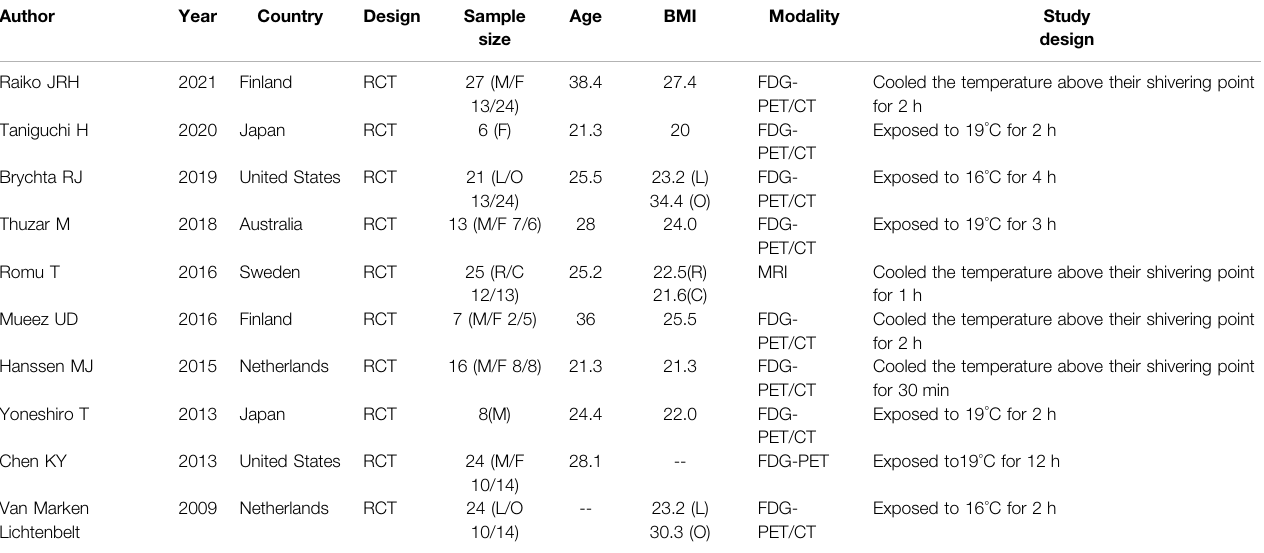
TABLE 1 | Characteristics of eligible